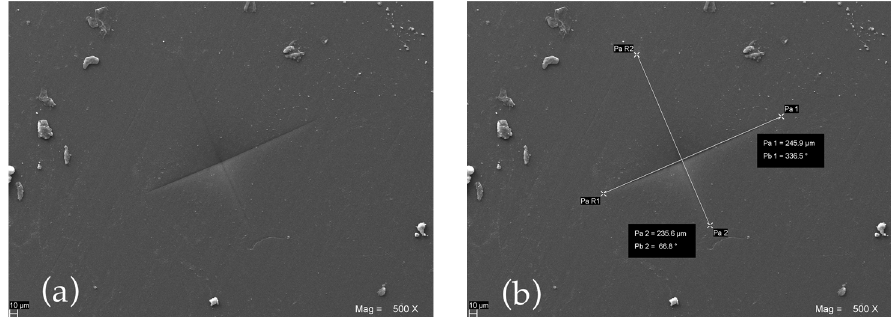
Figure 7. Scanning electron micrograph showing a VH indentation ( a ) and the measurement of its diagonals ( b ) performed on a specimen of G-PMMA.